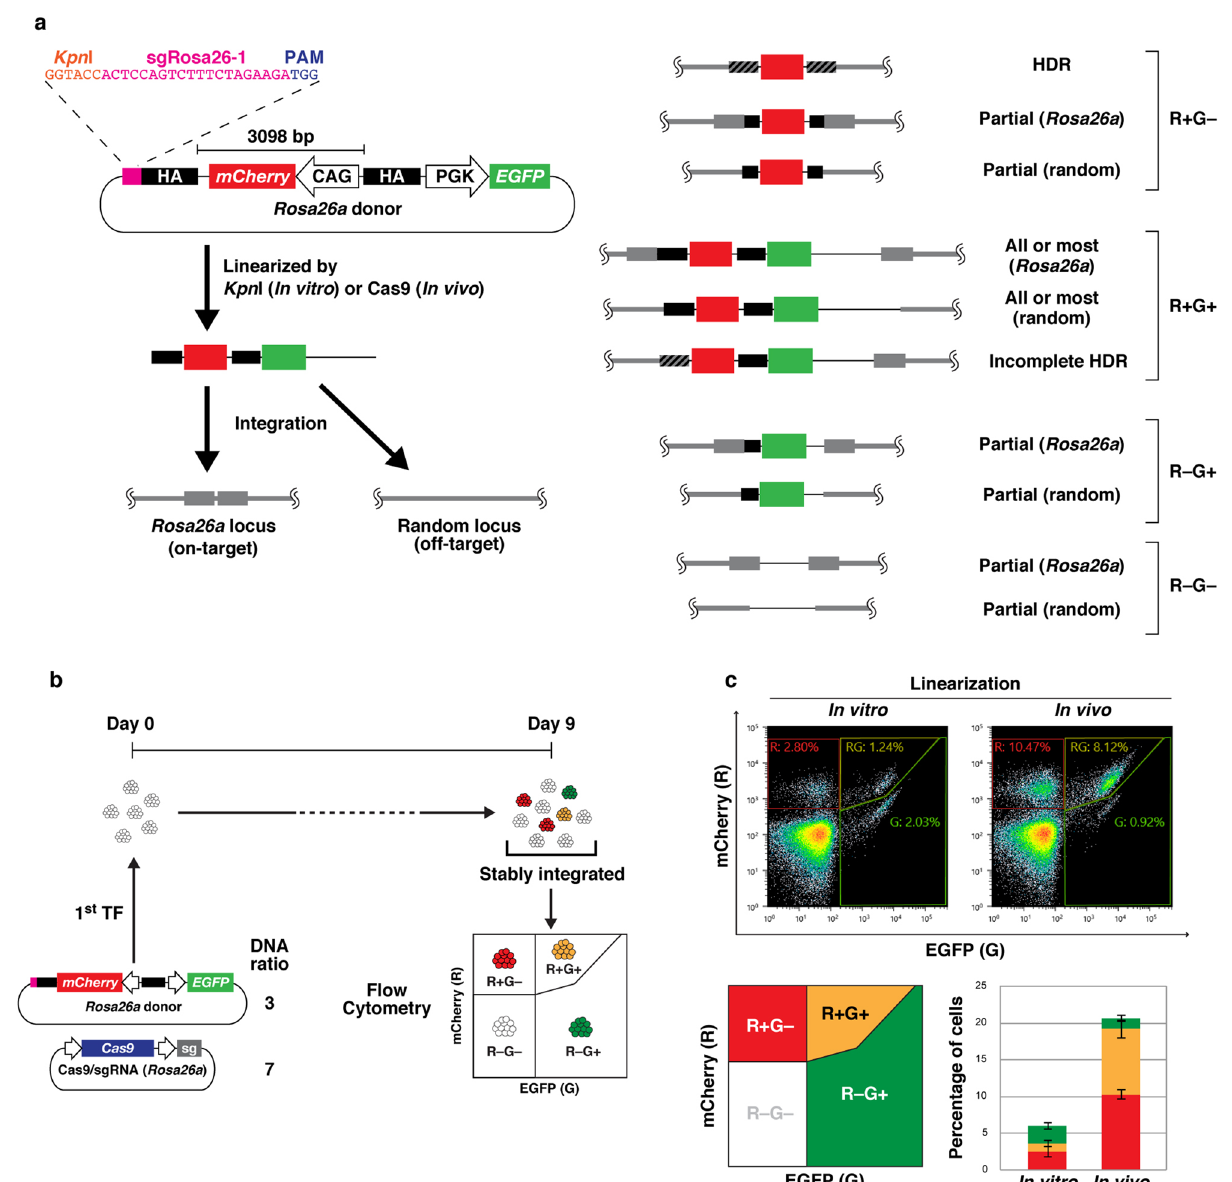
Figure 1. Comparison of methods to linearize plasmid donors. ( a ) Schematic illustration of the Rosa26a donor and possible modes of integration. Wide black bars and wide gray bars indicate the homology arms in the donor and the homologous region in the genome, respectively. Black-and-gray striped bars denote the homologous region undergoing HDR. The pink bar indicates the sgRNA target sequence (sgRosa26-1). ( b ) Experimental scheme. Weight ratio of donor DNA and Cas9/sgRNA expression vector is shown. ( c ) Flow cytometry analysis of mESCs transfected with the Rosa26a donor and Cas9/sgRNA expression vector. A series of experiments, from transfection to flow cytometric analysis, was independently performed in triplicate. Scatter plots show representative results from three experiments. The average ± standard deviation percentages of R+G− (red), R+G+ (yellow), and R−G+ (green) cells are shown in the stacked bar